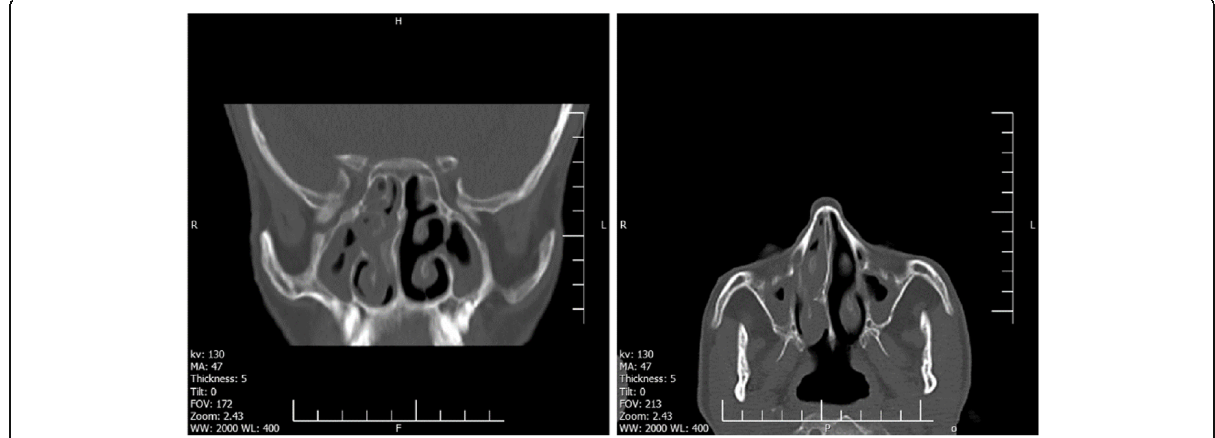
Fig. 6 Coronal and axial cuts of the sinuses. Ostiomeatal complex pattern is seen, as both the ethmoidal, maxillary, and frontal sinuses are involved